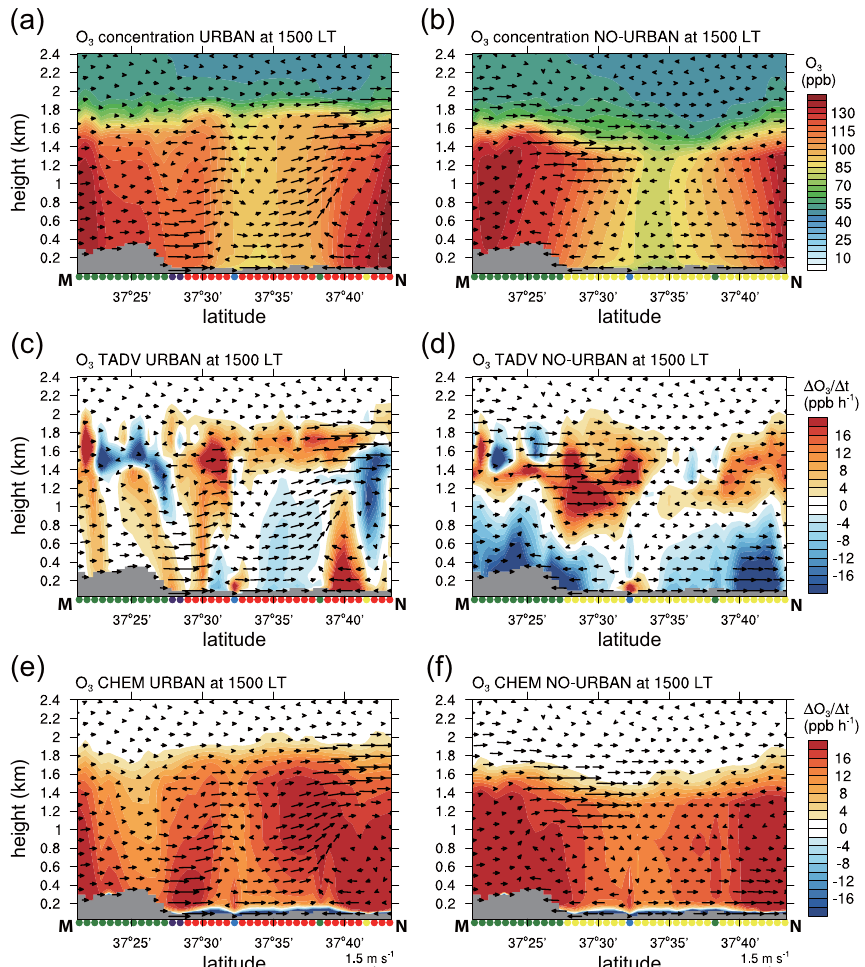
Fig. 10. Vertical cross sections of (a) O 3 concentration, (c) contribution of the advection process, (e) contribution of the chemical process to O 3 concentration, and wind along the line M–N in Fig. 1d at 15:00 LT in the URBAN simulation. (b) , (d) , and (f) are the same as (a) , (c) , and (e) , respectively, but for the NO-URBAN simulation. The color of circles on the x-axis corresponds to the color of the LULC in Fig. 1b.